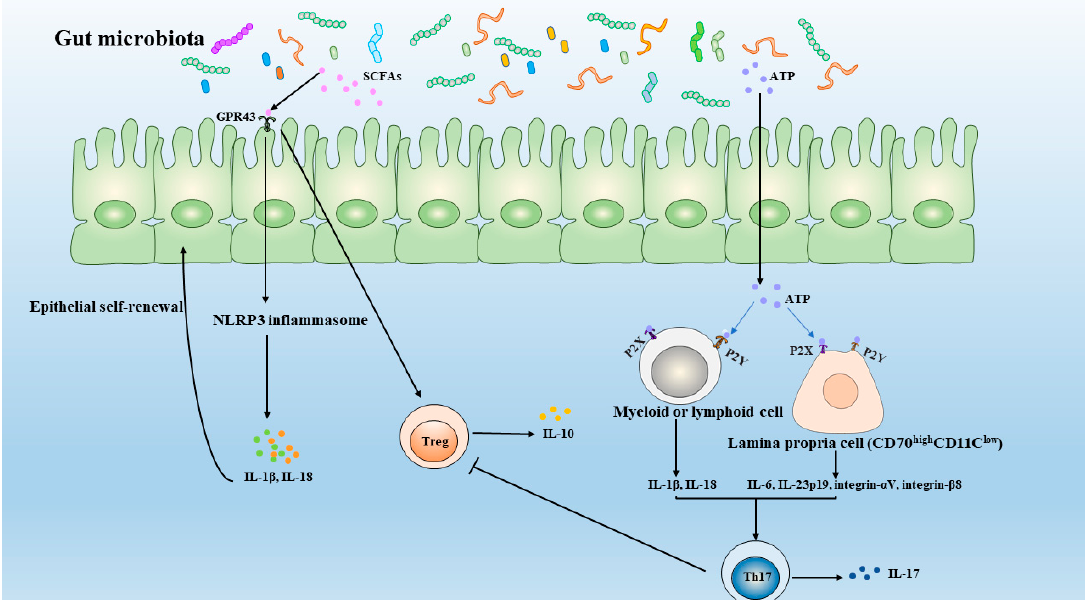
Figure 2. Metabolites of gut microbiota affect the balance of Th17 and Treg.